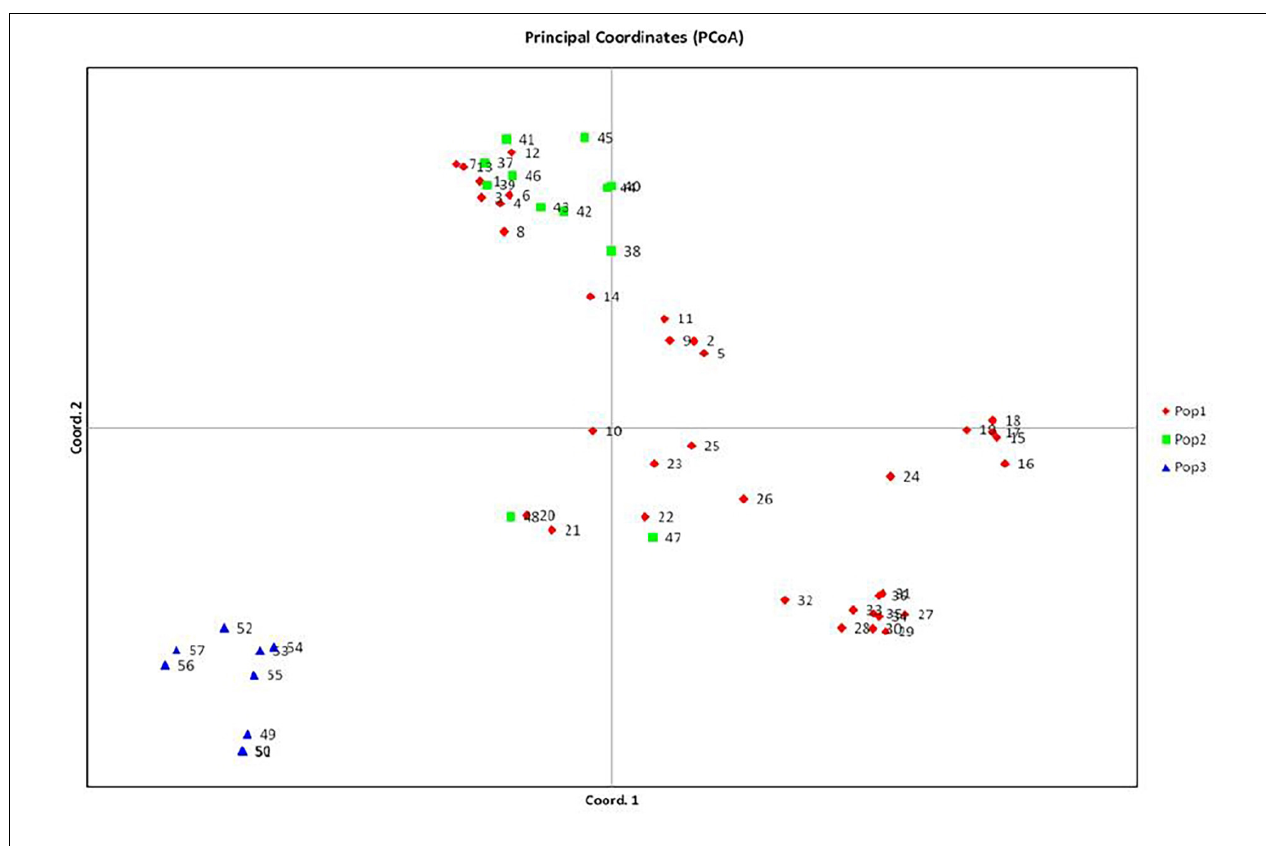
FIGURE 5 | PCA analysis of Pteris vitata .